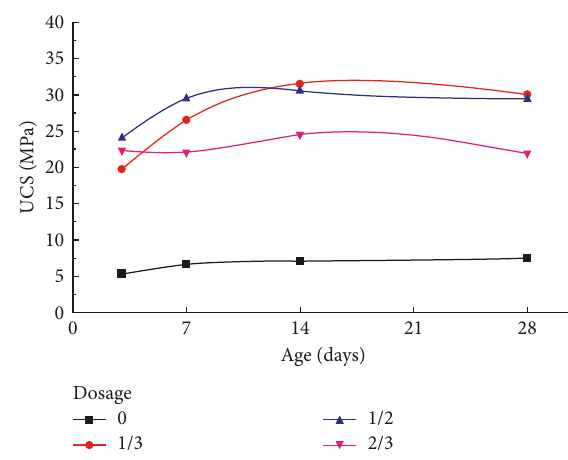
Figure 1: Compressive strength of different magnesium oxide